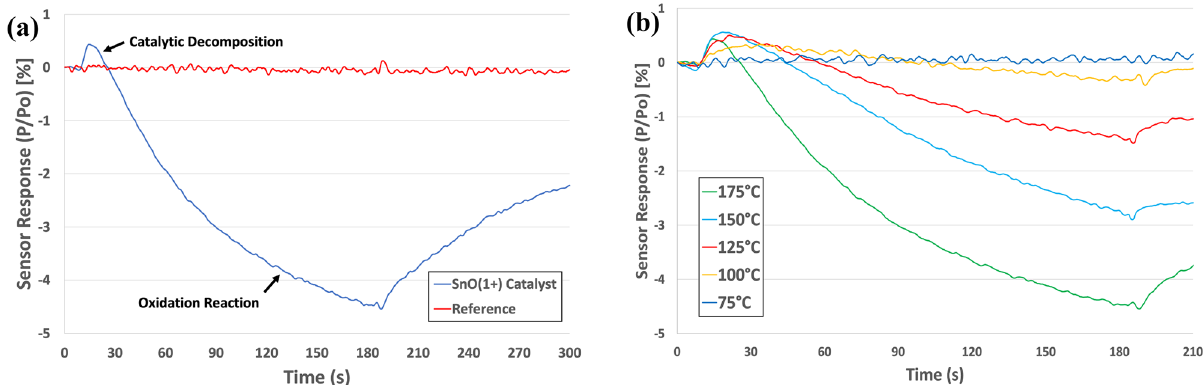
Figure 1. Response of a thermodynamic sensor to 5 ppm of ammonia. The sensor employed a SnO 1+ catalyst ( a ) Response of a thermodynamic sensor employing a SnO 1+ catalyst to 5 ppm ammonia at a variety of temperatures ( b